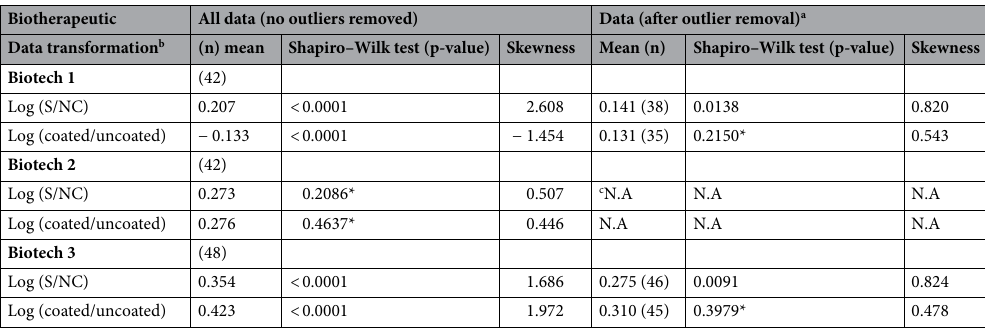
Table 1. Impact of different data transformations on distributional properties for resultant ADA tier 1 screening cut points. a Outliers were removed using outlier box plots in JMP (SAS institute, ver. 15.2.1). b Individual results obtained by the direct binding assay described in the “Materials and methods” section underwent data transformation using Log (S/NC) and Log (coated wells/uncoated wells). c N.A., not applicable. Initial data sets were normal and, thus, did not require outlier removal. *Indicates the sample distribution is normal by Shapiro–Wilk test (p > 0.05).